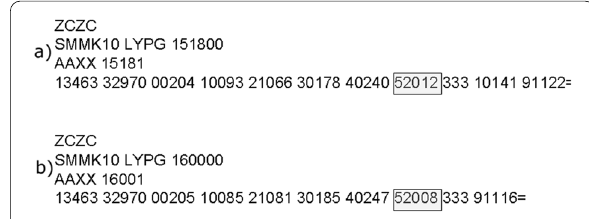
Fig. 9 SYNOP report MS Podgorica (Montenegro) for 15.01.2022 at 18 UTC ( a ) and 16.01.2022 at 00 UTC ( b